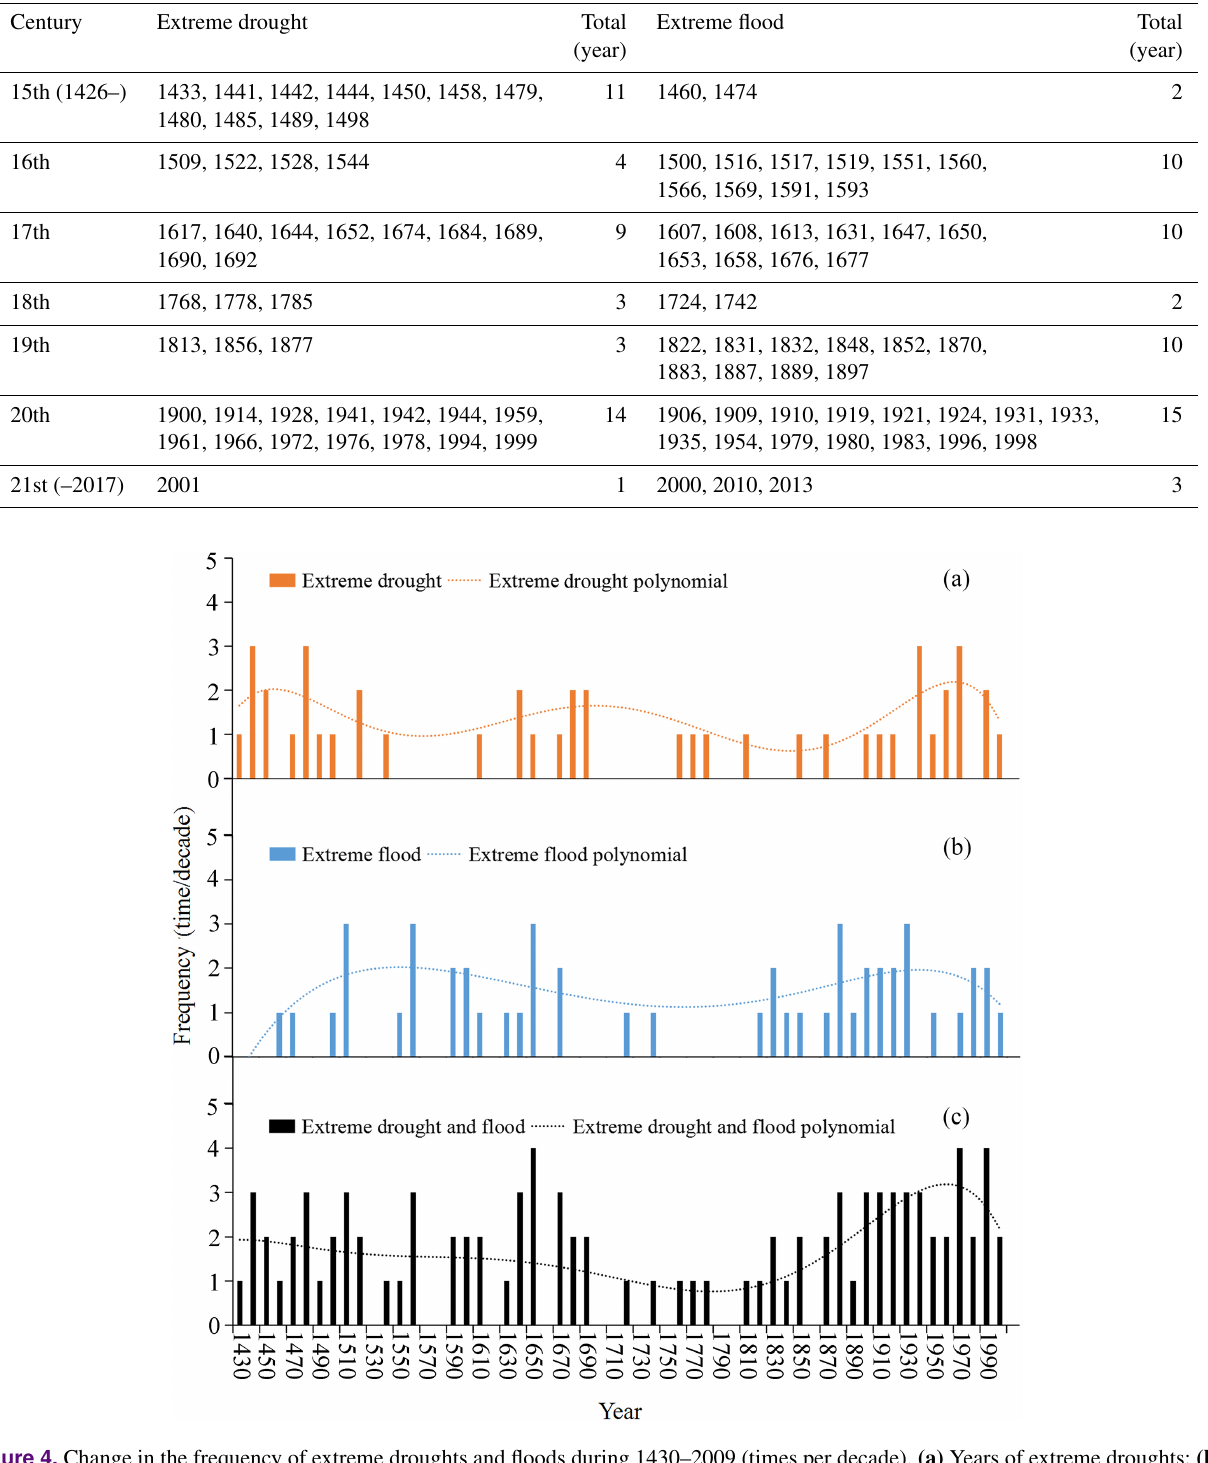
Clim. Past, 18, 1775–1796,